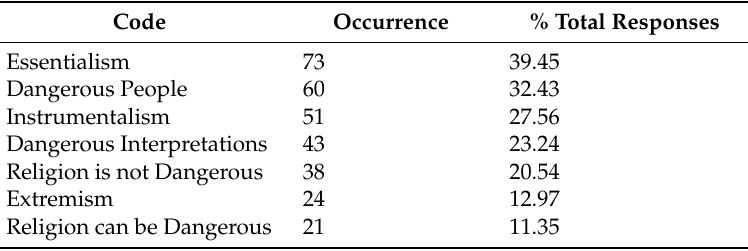
Table 2. Question 23: Religion is Dangerous: